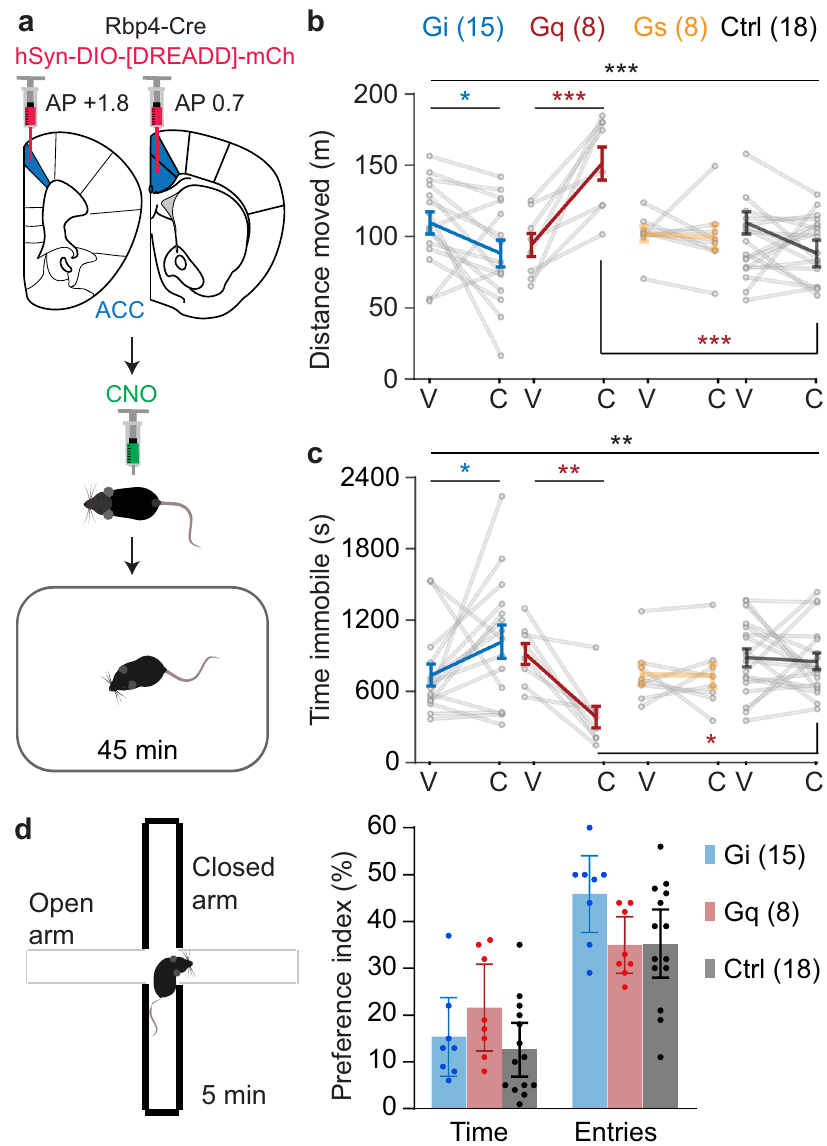
Fig. 4 The G q - and the G i -cascades in ACC L5-PCs have antagonistic effects on locomotor activity. a Experimental set-up. Locomotor activity in a novel open- fi eld assessed by total distance moved ( b ) and total amount of time spent immobile ( c ) during the 45 min test after injection of vehicle or CNO. Group identity and N -numbers stated in b . Black stars on top line indicate signi fi cant drug-group interaction (RM-ANOVA); coloured stars on horizontal lines below indicate a signi fi cant difference between vehicle and CNO conditions in the group coded by the colour (Sidak paired post-hoc test); coloured stars below data points indicate signi fi cant difference to the corresponding value in the Ctrl group (Sidak post-hoc test). d Exploration/anxiety ratio assessed by the preference to visit the open arm of an elevated plus-maze after injection of CNO. Group identity and N -numbers stated in colour legend. See Supplementary Tables 3 and 7 for statistics and reasons for varying N -numbers across experiments, respectively. 1 mg/kg CNO was used for the G q - group and a subset of Ctrl mice, 10 mg/kg was used for the remainder. * P < 0.05; ** P < 0.01; *** P ≤ 0.001; error bars, C.I.; individual dots or dot-lines represent